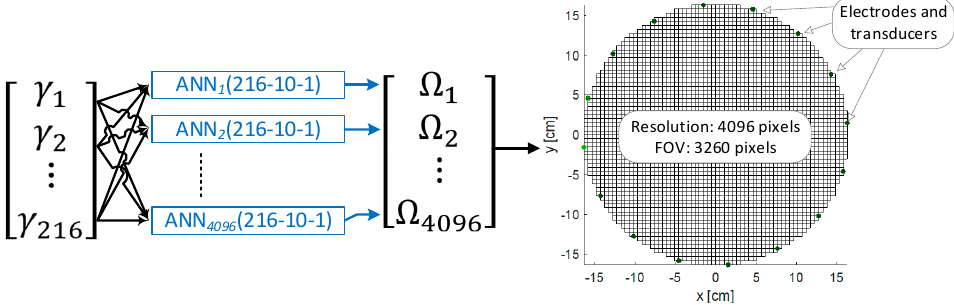
Figure 7. Multiple artificial neural network (MANN) system operation diagram.